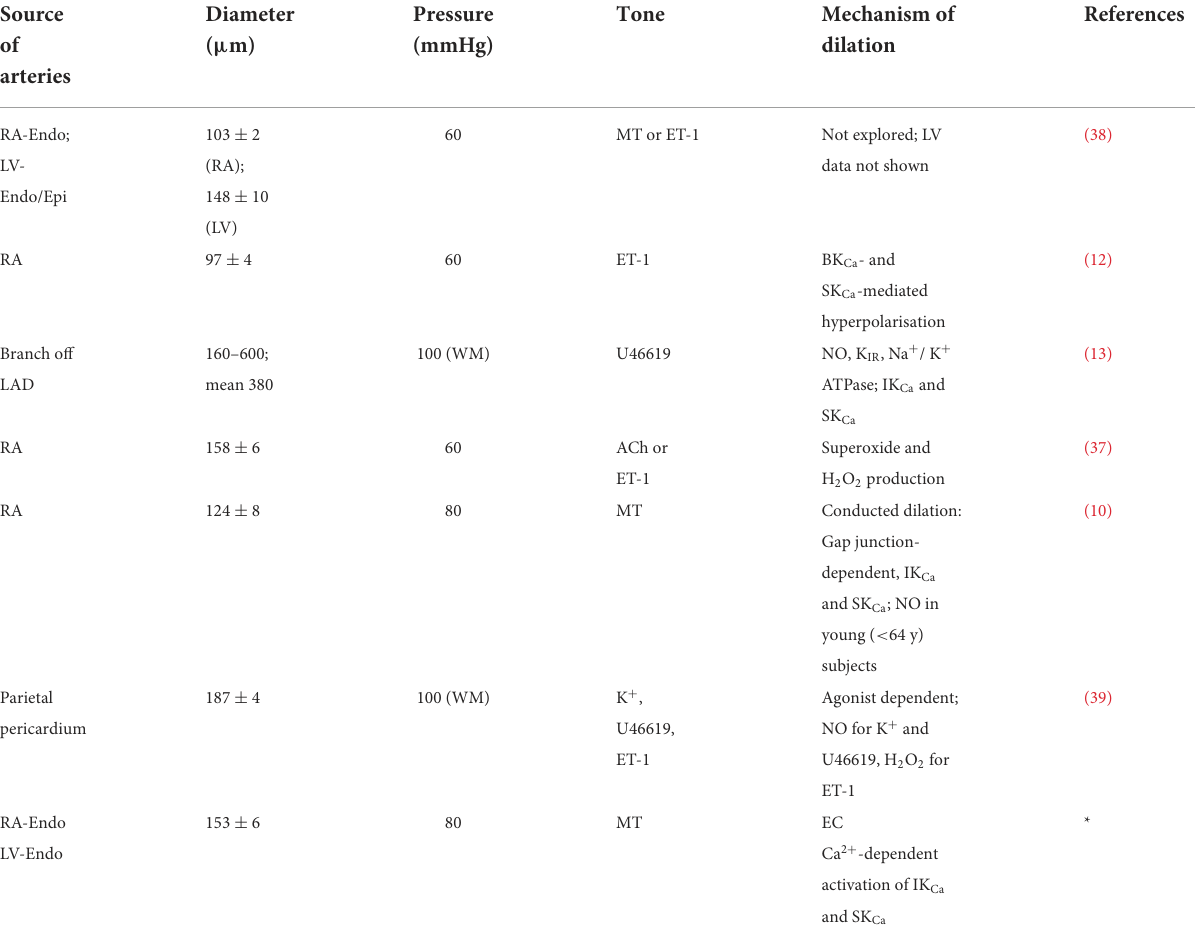
TABLE 3 Summary of some key published responses to bradykinin in human